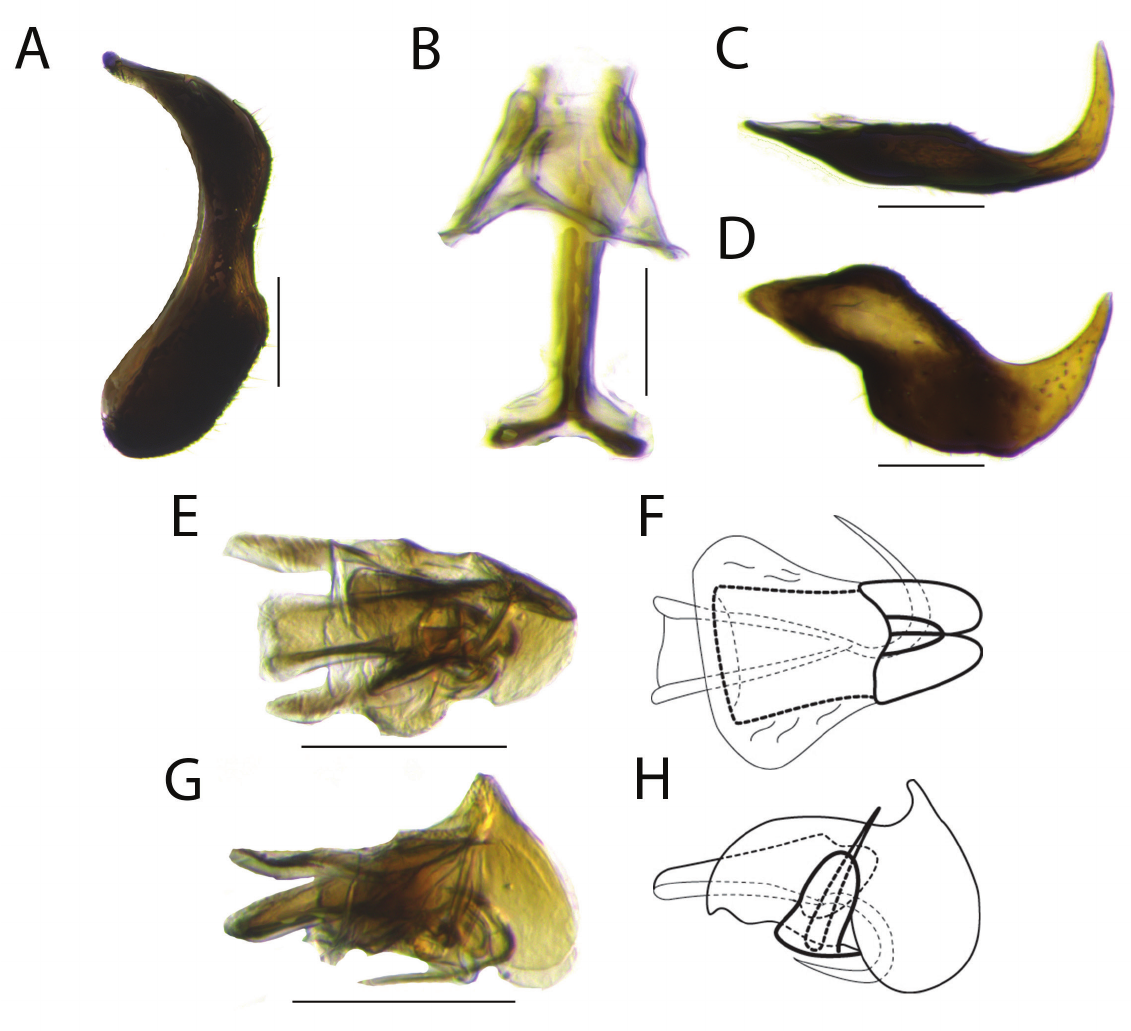
Fig. 2. Male terminalia of Aphelonema brevata Caldwell, 1945 (INHS). A . Pygofer, lateral view. B . Connective, anterior view. C–D . Style. C . Dorsal view. D . Lateral view. E–H . Phallus. E–F . Dorsal view. G–H . Lateral view. Scale bars = 0.1